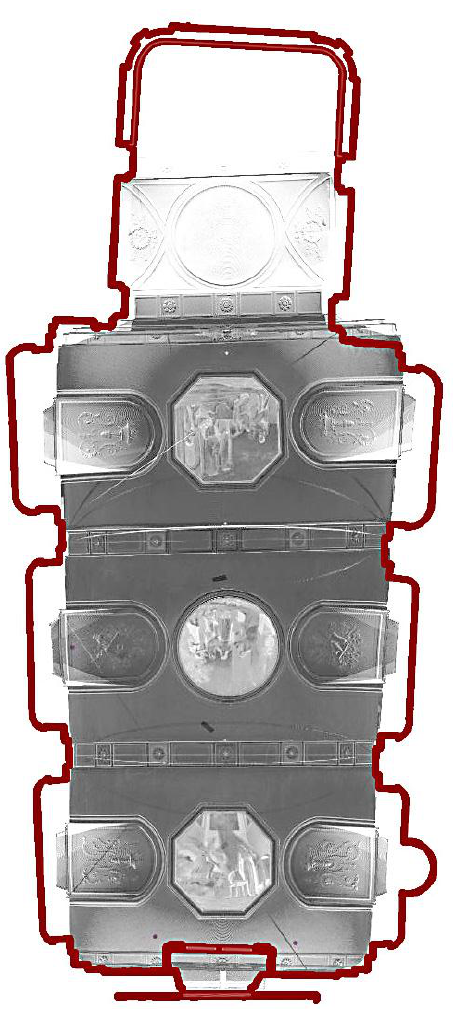
Figure 14. Survey and ortophoto of the roof